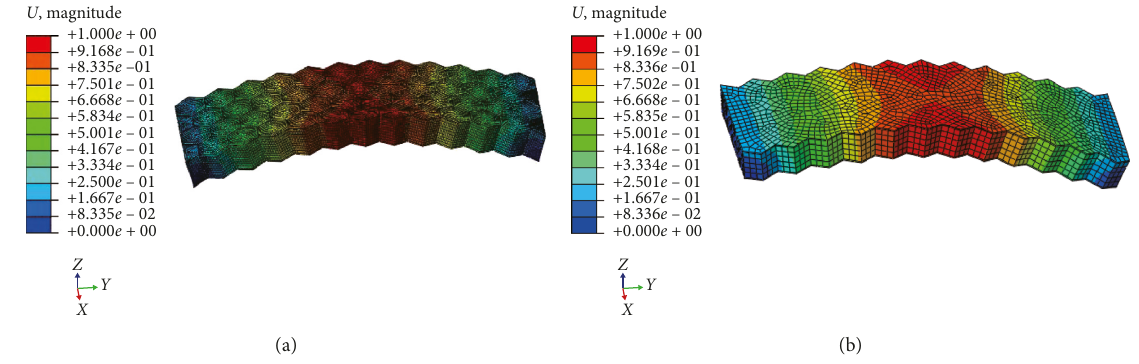
Figure 8: First-order modal shape. (a) Detailed model. (b) Equivalent